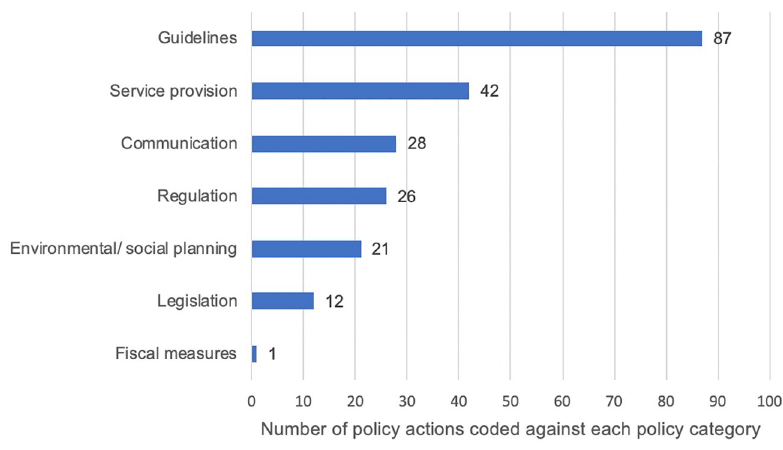
Fig 4. Policy actions coded by ‘policy